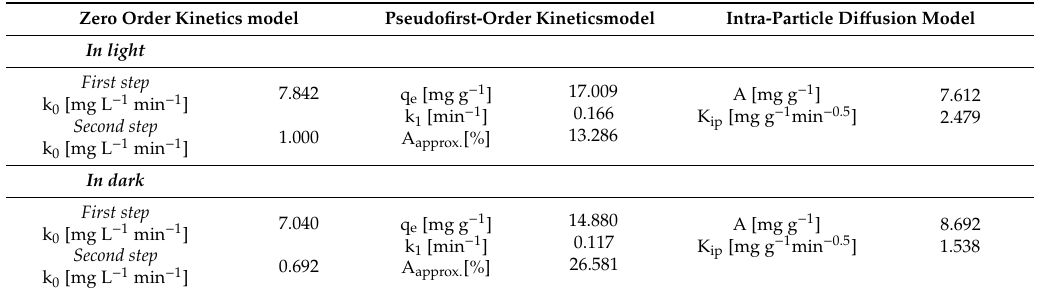
Figure 1. Kinetics of the silver ions onto casein sorption process in light and dark conditions. The kinetic steps of the Ag + ions sorption by casein and values of the rate constants determined using zero order kinetic model ( A ); sorption effectiveness of the Ag + ions by casein ( B ); experimental data and fitted pseudo first-order kinetics models of the Ag + ions sorption by casein ( C ); and plot of intra-particle diffusion model of the Ag + ions sorption onto casein ( D ). Table 1. Kinetic models parameters for the silver ions sorption by casein under light and dark